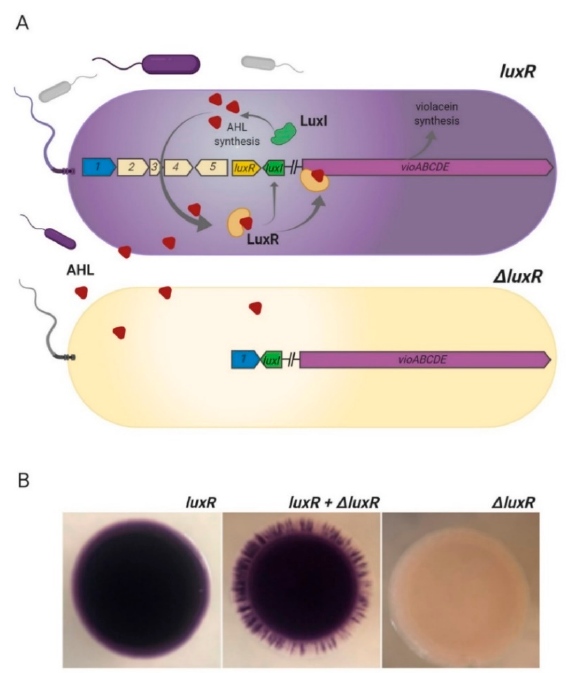
Figure 4. Nature of the unpigmented strain. ( A ) Mechanism of luxI/luxR regulation of violacein production and inability to develop pigmentation in natural Δ luxR isolate. LuxR binds with exogenous AHL and activates LuxI production; LuxI syntheses endogenous AHL; increasing AHL concentration amplify AHL-QS signaling loop; increasing concentration of LuxR-AHL complex activates the vioABCDE operon and bacteria produce violacein. In case of the ∆ luxR strain, AHL signaling is interrupted and vioABCDE is not active. Unpigmented natural isolate of C. vaccinii has deletion of luxR and 1-5 protein-coding genes. ( B ) Inability of natural ∆ luxR isolate to produce violacein in a mixed biofilm colony model. Biofilm colonies formed by pigmented strain ( luxR) ; mix of pigmented and unpigmented strains (luxR + ∆ luxR); unpigmented strain ( ∆ luxR). Mixed biofilm colony has clear patterns of pigmented and unpigmented zones, which indicates the inability of ∆ luxR strain to respond and amplify AHL-QS signal and produce violacein in a mixed bacterial population. Picture was created with